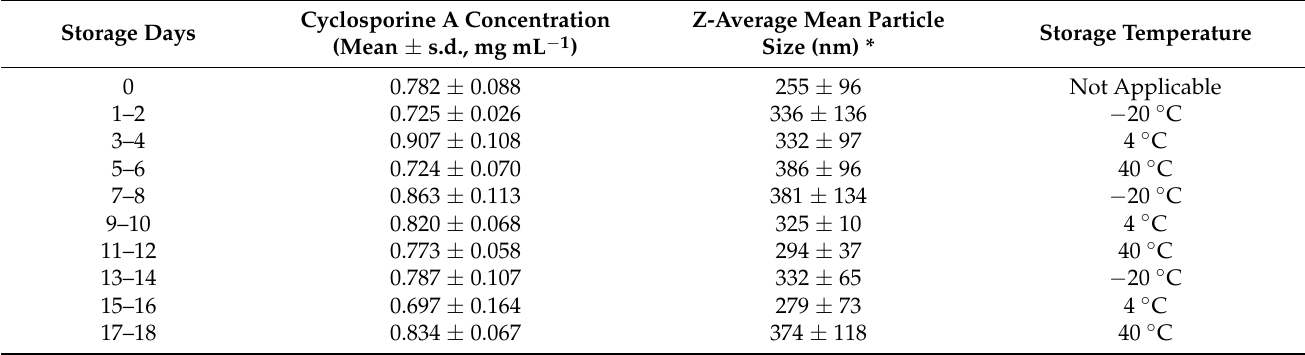
Table 6. NM133 0.08% C Storage Stability Studies Following Freeze Thaw Cycling, mean ± s.d. from three independent samples. Storage Days